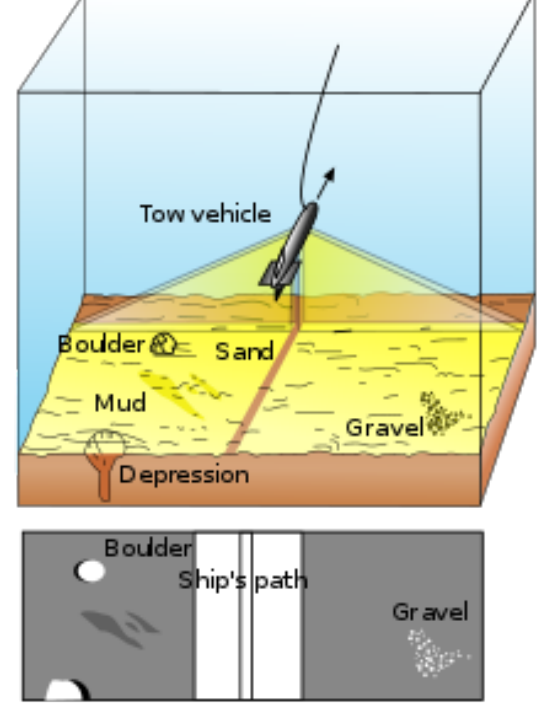
Figure 1. Side-scan-sonar principle. Source: